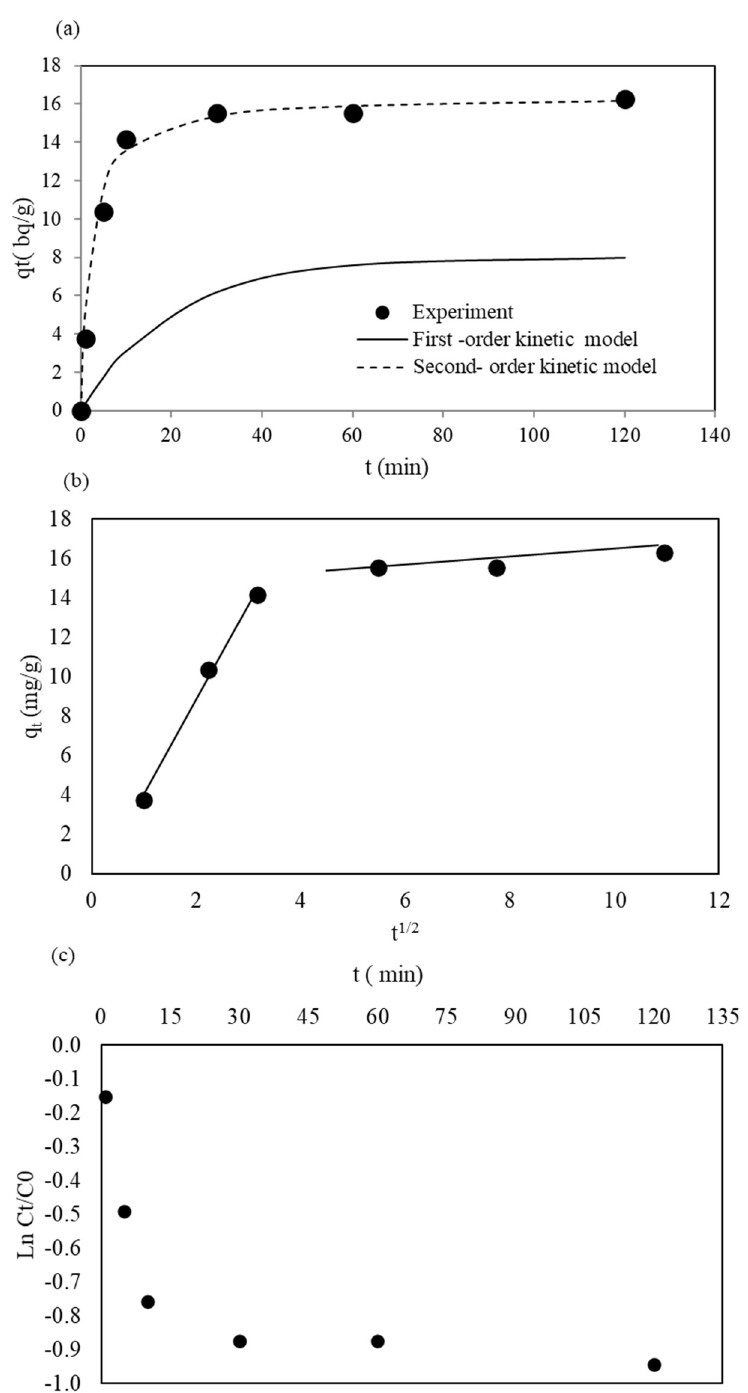
Figure 7. ( a ) Kinetics of data and fitted models of radium adsorption of WTBS, ( b ) plot of the intraparticle diffusion model and, ( c ) plots of the external diffusion model.